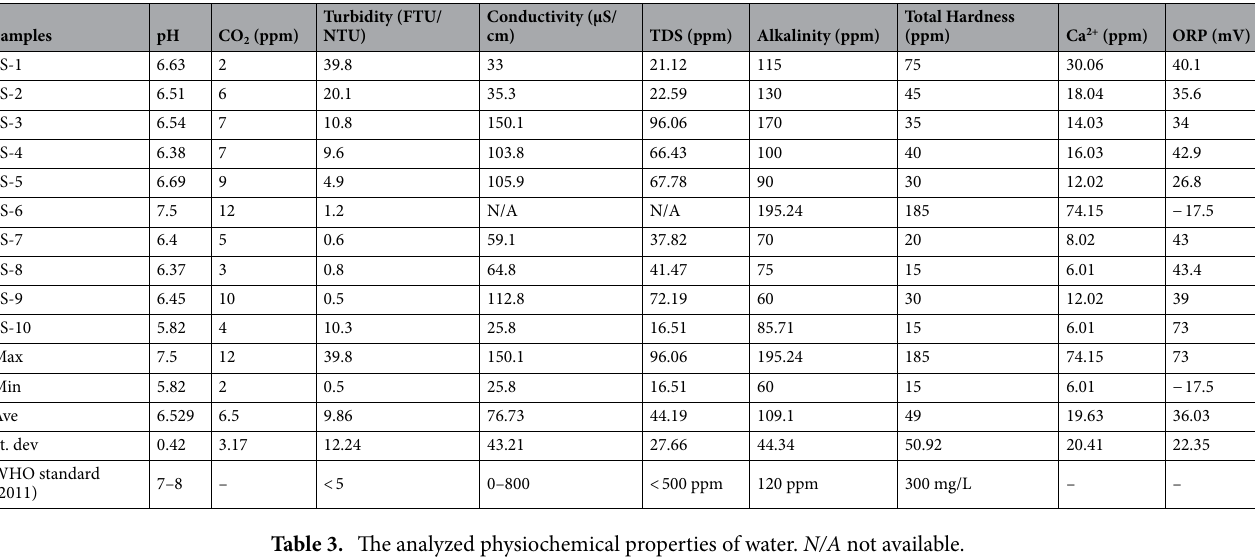
Table 3. The analyzed physiochemical properties of water. N/A not available.